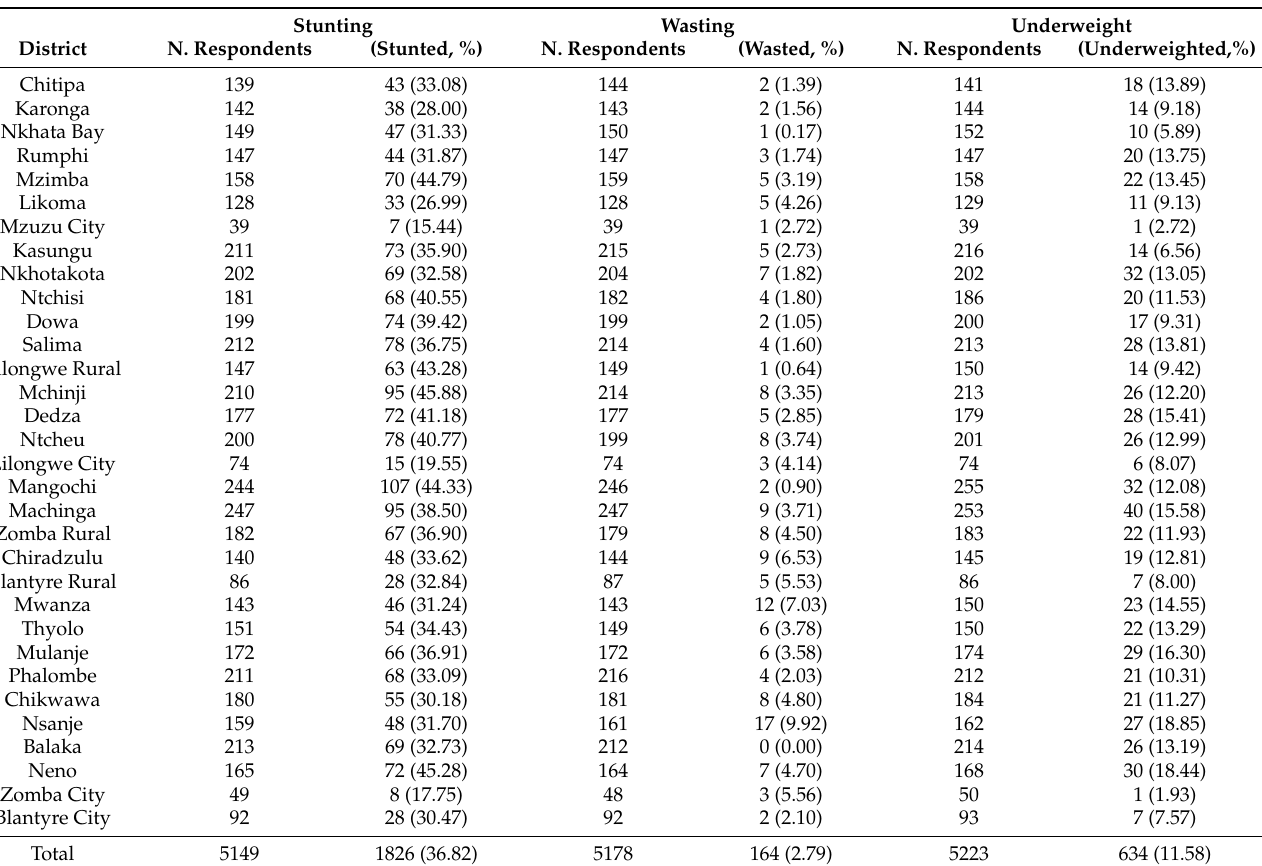
Table A1. Summary of the observed (weighted) prevalence rates of stunting, wasting, and under- weight per district in